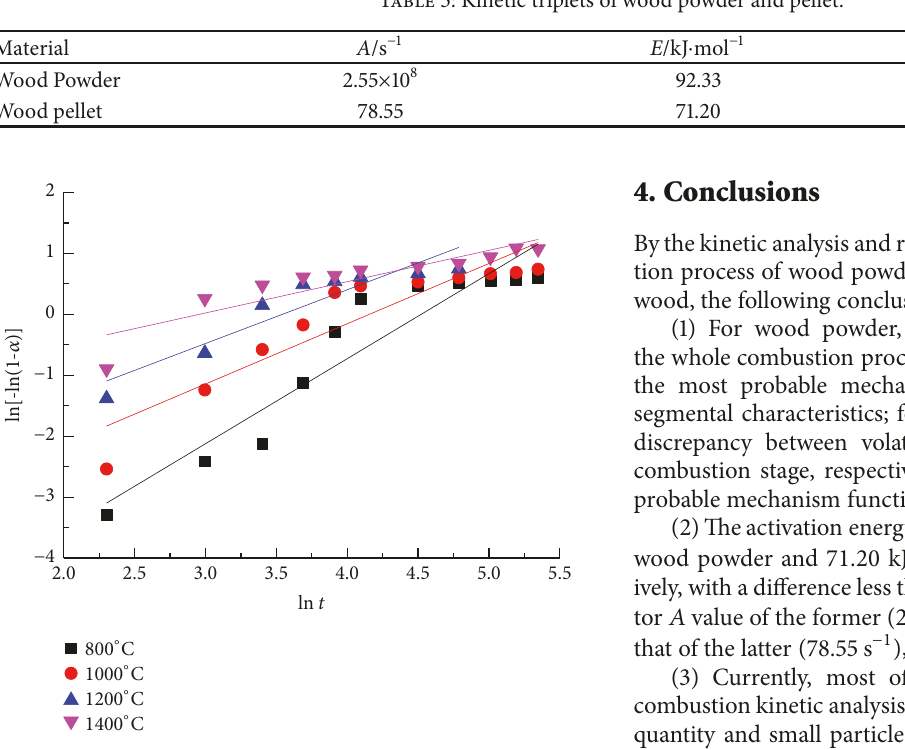
Figure 5: The linear relationship of ln[-ln(1- 𝛼 )]-ln t .